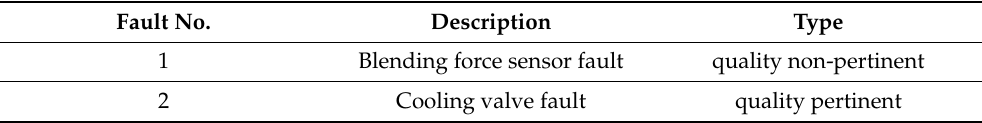
Table 4. Information of faults. Fault